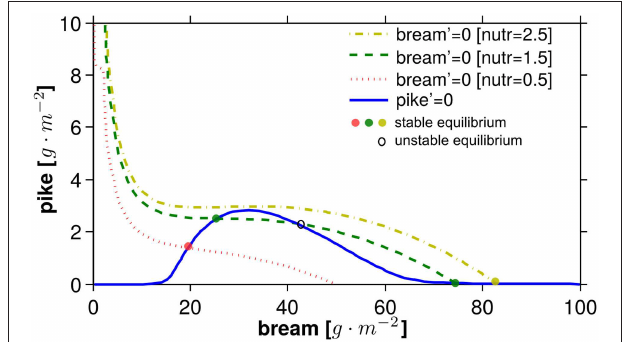
FIGURE 4 | State-space diagram showing zero-isoclines for bream and pike with different stable states depending on the nutrient level that influences the position of the zero-isocline for bream. The zero-isocline for pike is unaffected by the nutrient level. Reimplementation is based on the model developed by Scheffer